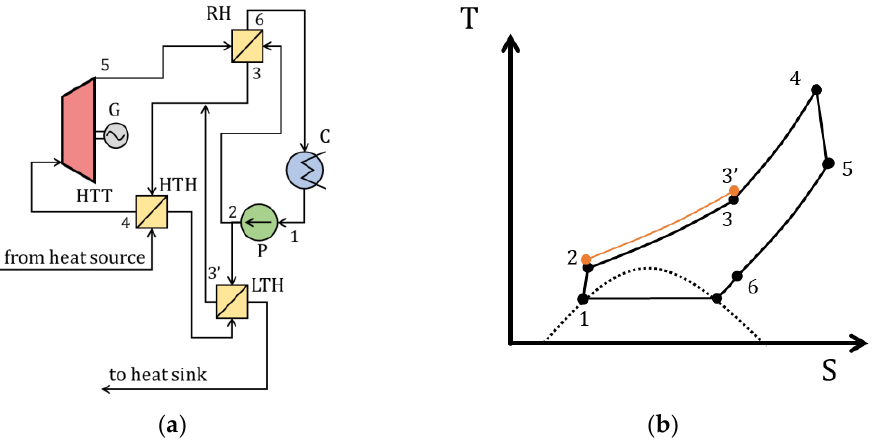
Figure 11. Split Rankine cycle with regeneration: ( a ) schematic diagram; ( b ) T–S diagram [19]. HTT—high-temperature turbine; LTT—low-temperature turbine; G—generator; RH—regenerative heat exchanger; P—pump; LTH—low-temperature heater; HTH—high-temperature